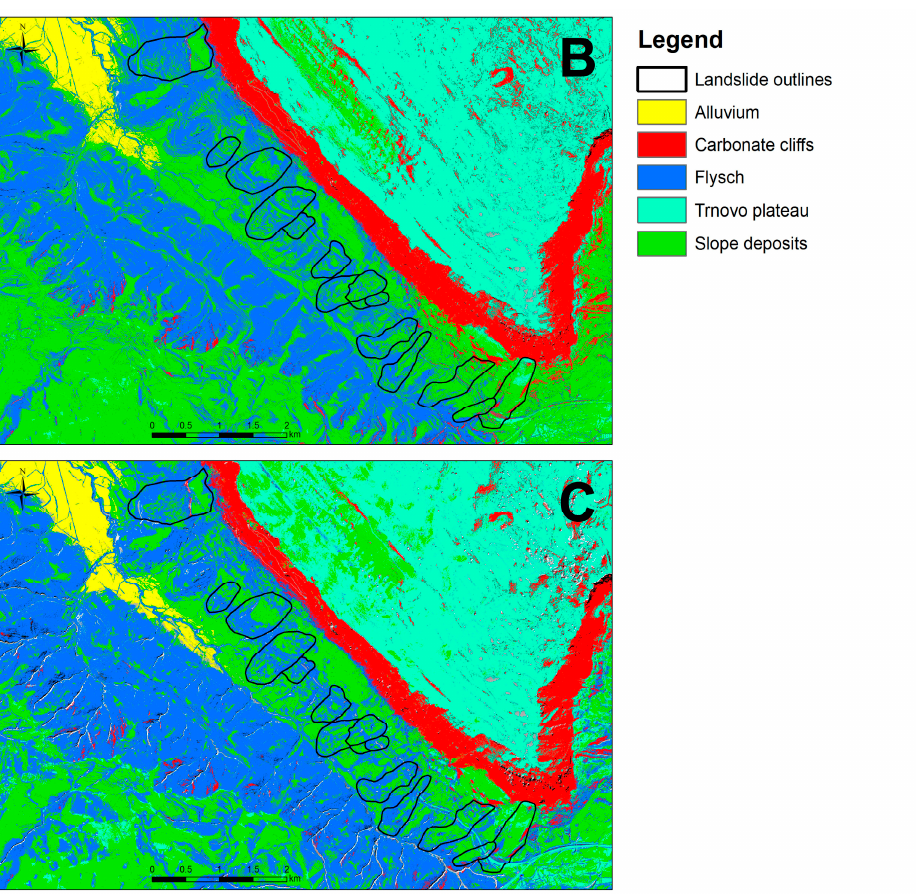
Figure 9. Rebrnice landslide area. ( A ) outlines and main sediments of the litho-geomorphological units; ( B ) original MLC results; and ( C ) results from this study. units; ( B ) original MLC results; and ( C ) results from this